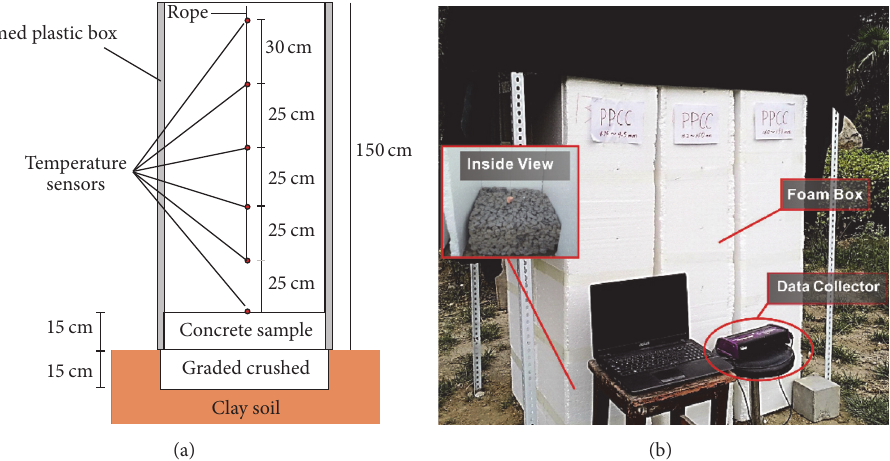
Figure 2: Near-surface air temperature monitoring device: (a) schematic figure of near-surface air temperature monitoring device; (b) photograph of near-surface air temperature monitoring device.